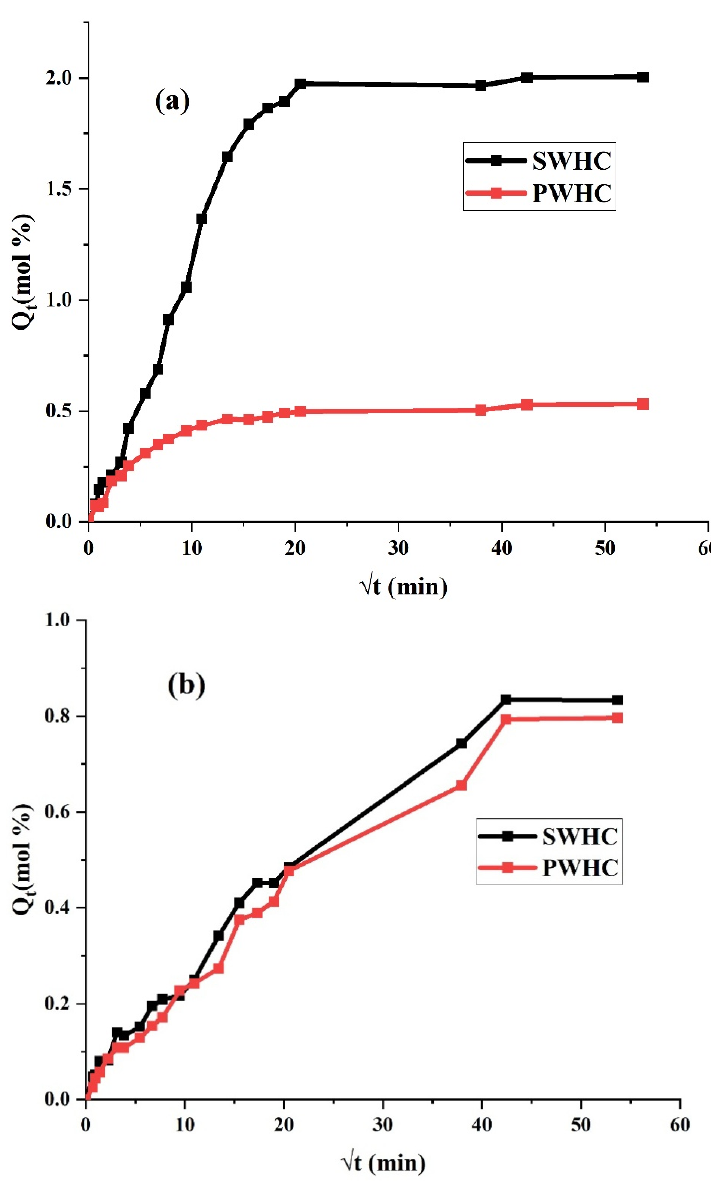
Figure 6. Diffusion curve of the SWHC and PWHC in ( a ) toluene ( b ) water. Table 5. Crosslink density and Mc of the SWHC and PWHC.